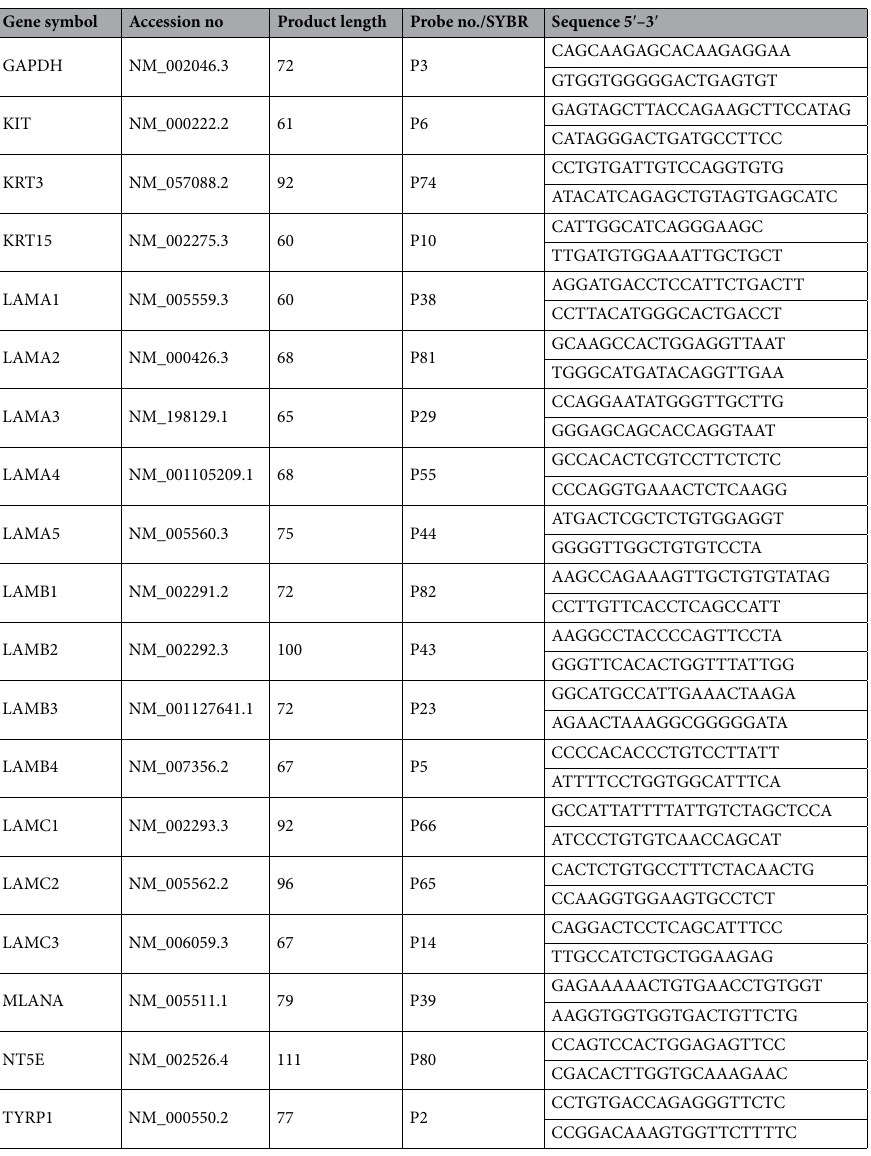
Table 1. Primers used in qRT-PCR primer assays. Primers were used for Probe based (Universal Probe Library) or SYBR Green based qRT-PCR assays with an annealing temperature of 60